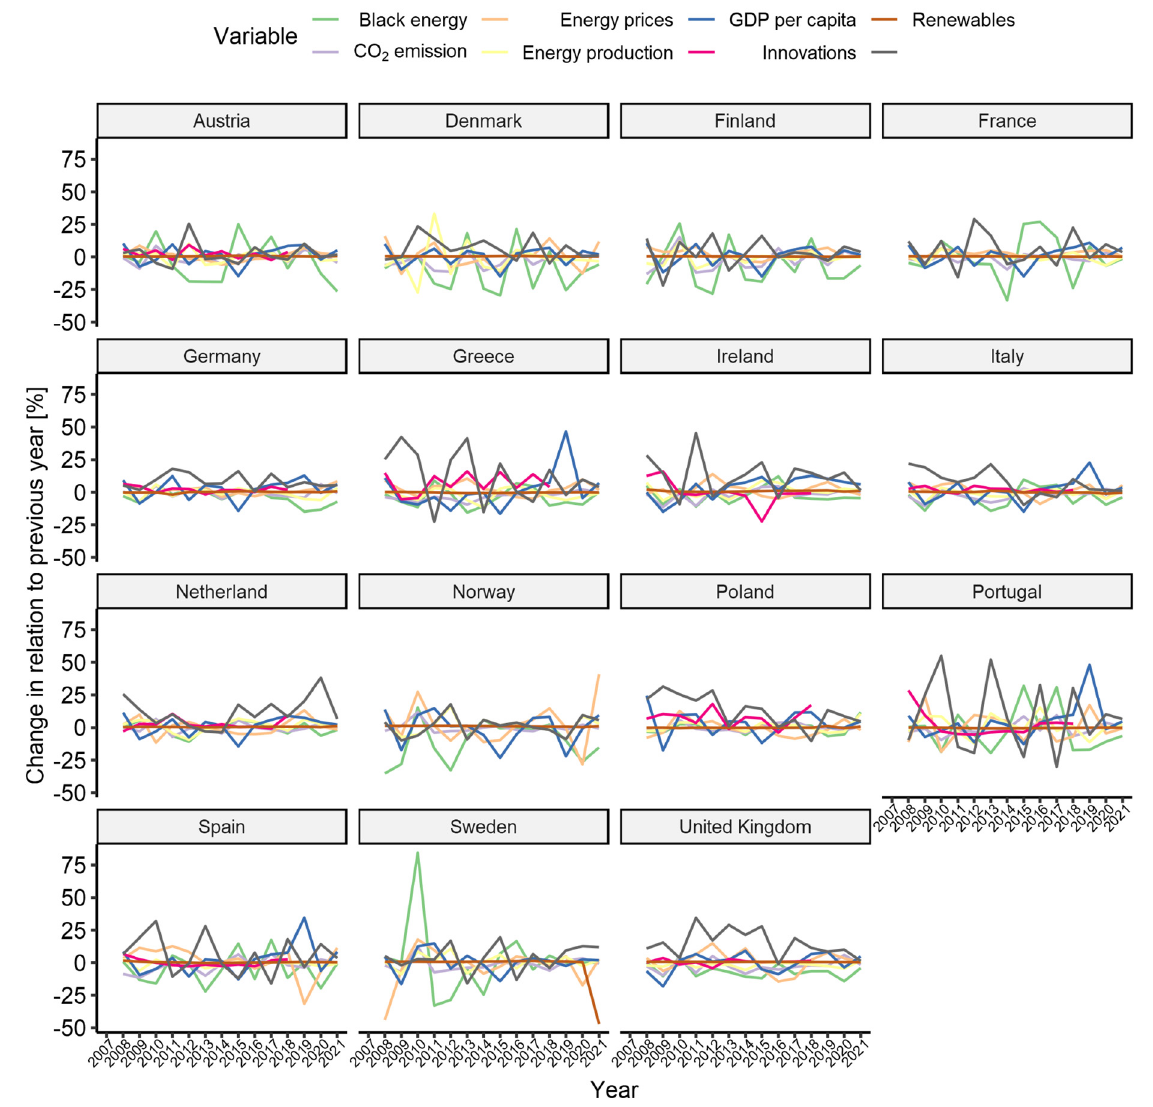
Figure 3. Relative changes in all variables used in the study.